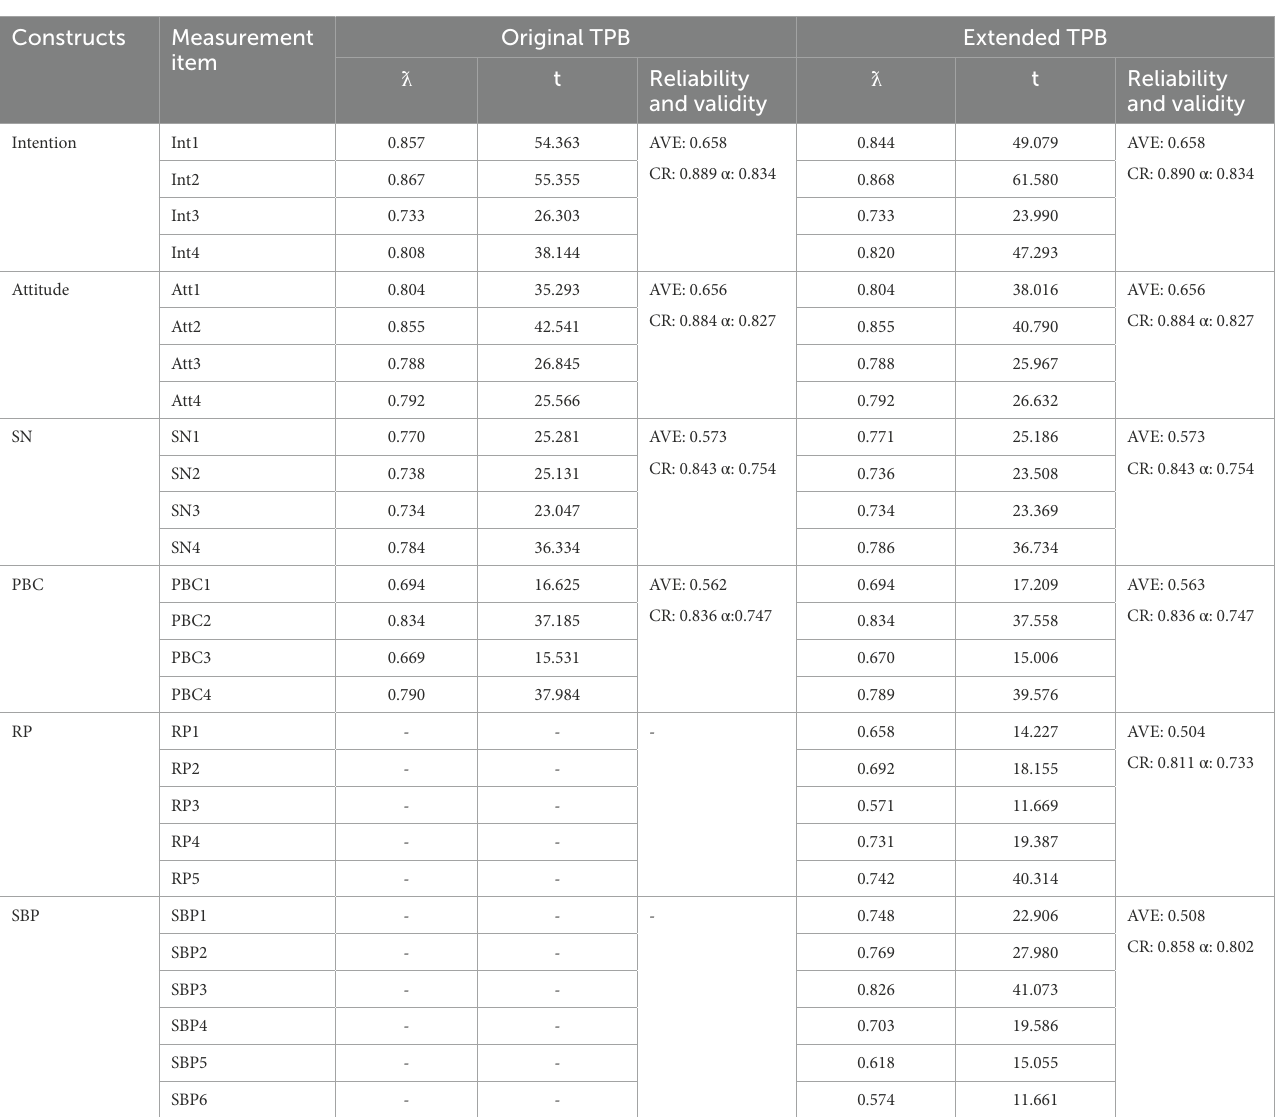
TABLE 3 The fit results of measurement models. Constructs